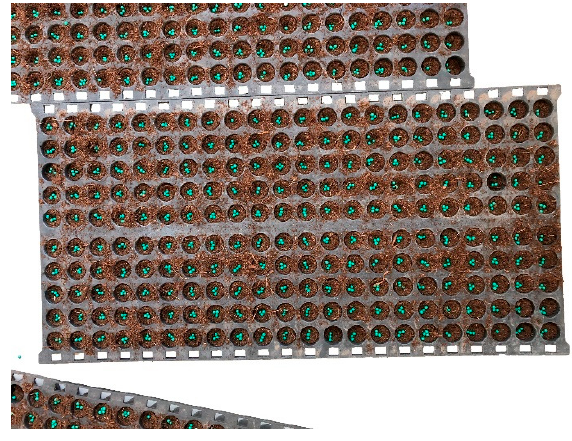
Figure 25. Some of the trays used in the experiment.